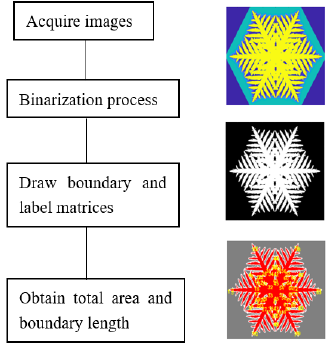
Figure 14. Snowflake growth data acquisition.